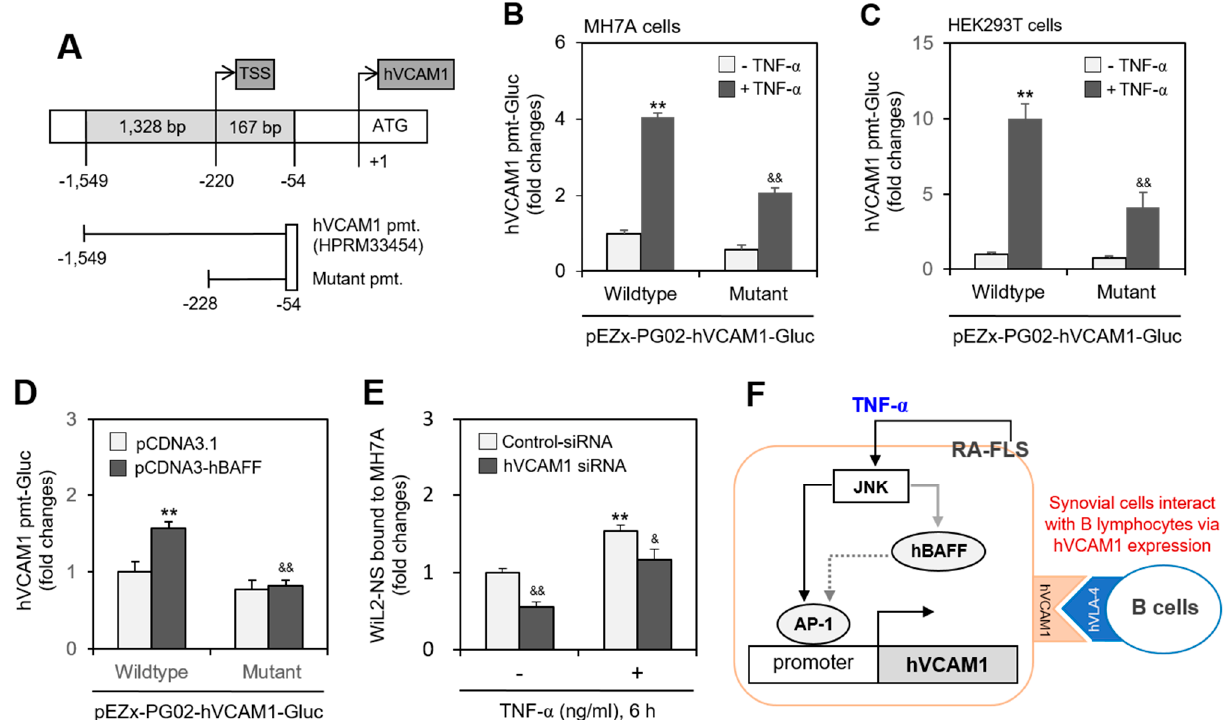
Figure 6. WiL2-NS cell bound to MH7A cells were enhanced by human vascular cell adhesion molecule-1 (hVCAM1) expression. ( A – C ) Mutant promoter to hVCAM1 was prepared from wild-type promoter ( A ). MH7A ( B ) or HEK293T ( C ) cells were transfected with wild- or mutant-type of pEZx-PG02-hVCAM gaussia luciferase (Gluc) plasmid DNA. Then, each cell was incubated for 30 h after transfection, and treated with 20 ng/mL TNF- α for additional 6 h. Gluc activity was measured by using luminometer ( B , C ). ( D ) MH7A cells were co-transfected with pCDNA3.1, or pCDNA3-hBAFF and wild or mutant type of pEZx-PG02-hVCAM-Gluc plasmid DNA by using PEI. Gluc activity was measured by using luminometer. ( E ) MH7A cells were transfected with control or hVCAM1-siRNA to knockdown hVCAM1 expression by using Lipofectamine ® and treated with 20 ng/mL TNF- α for 6 h. Then, WiL2-NS cells were added and co-incubated to adhere for 30 min. Unbound WiL2-NS B cells were washed out and MTT assay was used to analyze bound B cells. Each experiment was performed at least four times. Data in a bar graph represent the means ± SD. ** p < 0.01; significantly different from TNF- α -untreated ( B , C ) or pCDNA3.1-transfected ( D ) or control-siRNA-treated and TNF- α -untreated ( E ) control group. & p < 0.05, && p < 0.01; significantly different from control TNF- α -treated ( B , C ) or pCDNA3-hBAFF-transfected ( D ) or control-siRNA-treated and TNF- α -treated ( E ) control group. ( F ) This is a schematic interaction mechanism of B lymphocytes to synovial cells by hVCAM1 expression under TNF- α stimulation. It suggests that TNF- α -activated JNK controls hVCAM1 expression via AP-1 binding on its promoter (black solid line) in synovial cells. JNK also might induce hBAFF expression (grey solid line), which lead to the regulation of hVCAM1 expression by AP-1 binding on its promoter (grey dotted line) in synovial cells. Through this molecular mechanism, hVCAM1 can control the interaction of synovial cells to B